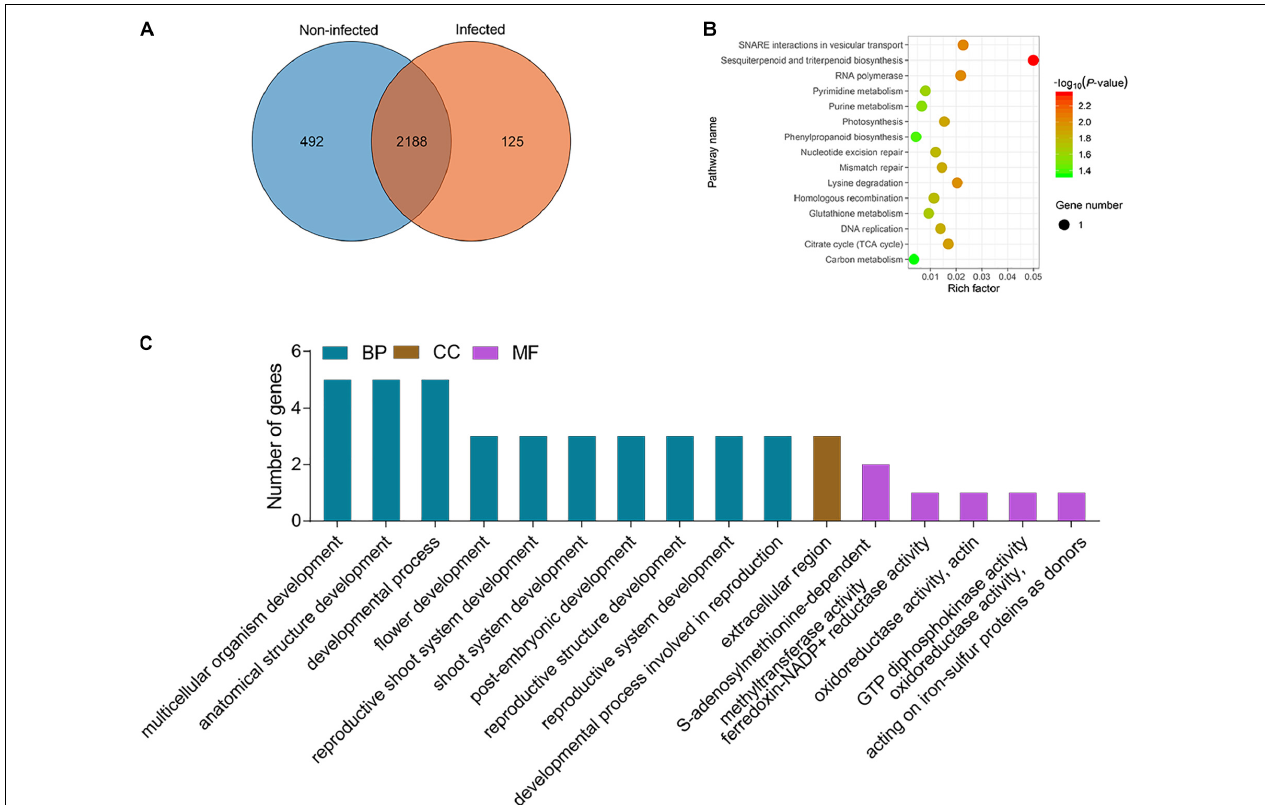
FIGURE 3 | Analysis of specific lncRNAs from P. infestans infected samples. (A) Venn gram showing the distribution of lncRNAs in infected (ht3, ht4, rt3, and rt4) and non-infected (ht0, rt0, mht0, mht3, mht4, mrt0, mrt3, and mrt4) samples. (B) KEGG enrichment analysis of targets of 213 specific lncRNAs from infected samples. The circle size represents the gene number. Green to red represents the low to high P -value. (C) GO terms enrichment analysis of targets of 125 specific DELs and the top 10 of biological process (BP), and top 5 of molecular function (MF) and cellular component (CC) are